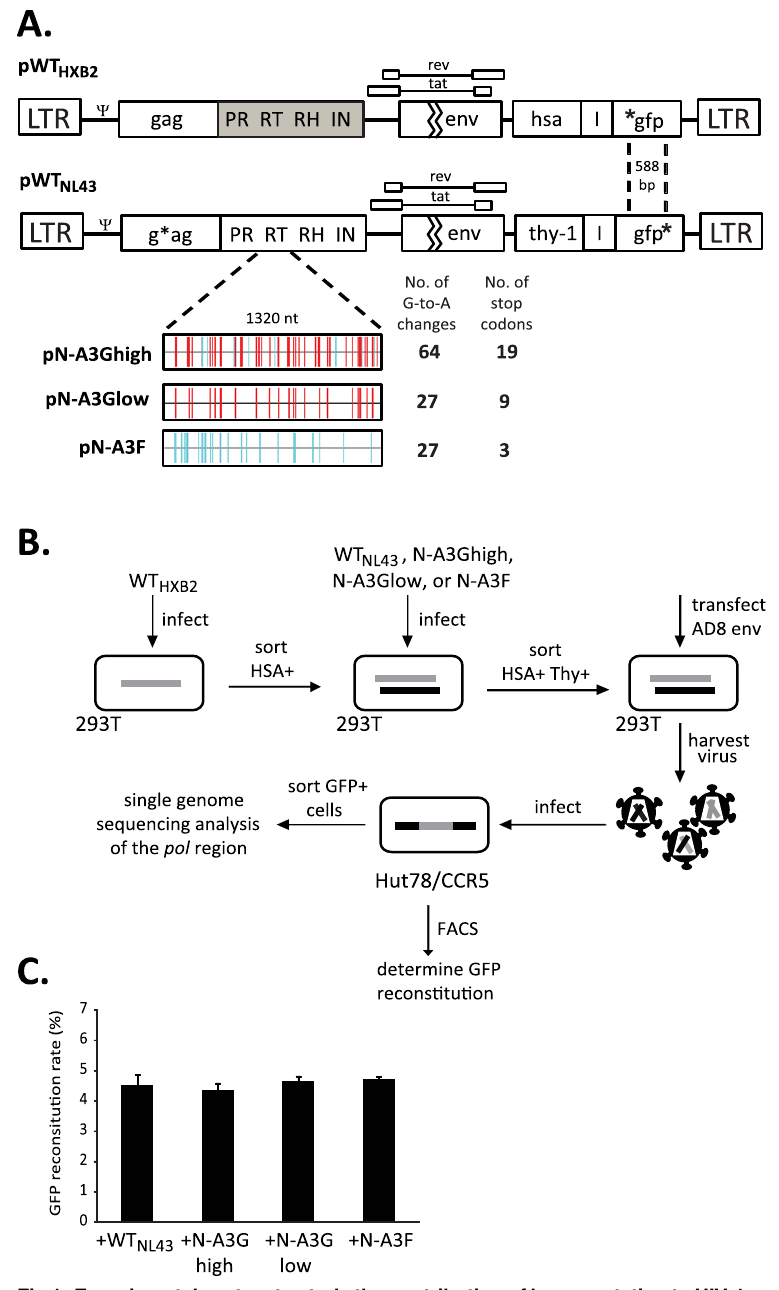
Fig 1. Experimental system to study the contribution of hypermutation to HIV-1 recombination and genetic variation. (A) Plasmids pWT HXB2 and pWT NL43 are HIV-1-based constructs expressing hsa -IRES- gfp or Thy -IRES- gfp , respectively, from the nef open reading frame. For pWT HXB2 , the pol region is replaced with HXB2 pol sequence (gray shaded region); gfp in the nef open reading frame contains an inactivating mutation at the 5 ’ end of gfp ( * gfp). For pWT NL43 , the pol region remains NL4-3 and gfp in the nef open reading frame contains an inactivating mutation at the 3 ’ end of gfp (gfp * ). The inactivating mutations in gfp are 588 bp apart. All constructs contain inactivating mutations in vif , vpu , vpr and env . * denotes inactivating mutations in gfp and gag genes. Constructs derived from pWT NL43 contain a modified RT region hypermutated by A3G (pN-A3Ghigh or pN-A3Glow), or by A3F (pN-A3F). The number of G-to-A changes relative to pWT NL43 and number G-to-A changes leading to a stop codon is shown on the right. Red vertical lines indicate GG ! AG mutations, while blue vertical lines indicate GA ! AA mutations (Hypermut [102]; www.hiv.lanl.gov). (B) Single cycle recombination system to study the effects of hypermutation. Briefly, 293T cells were infected with WT HXB2 -dervied viruses at a low MOI, and HSA + cells were enriched by